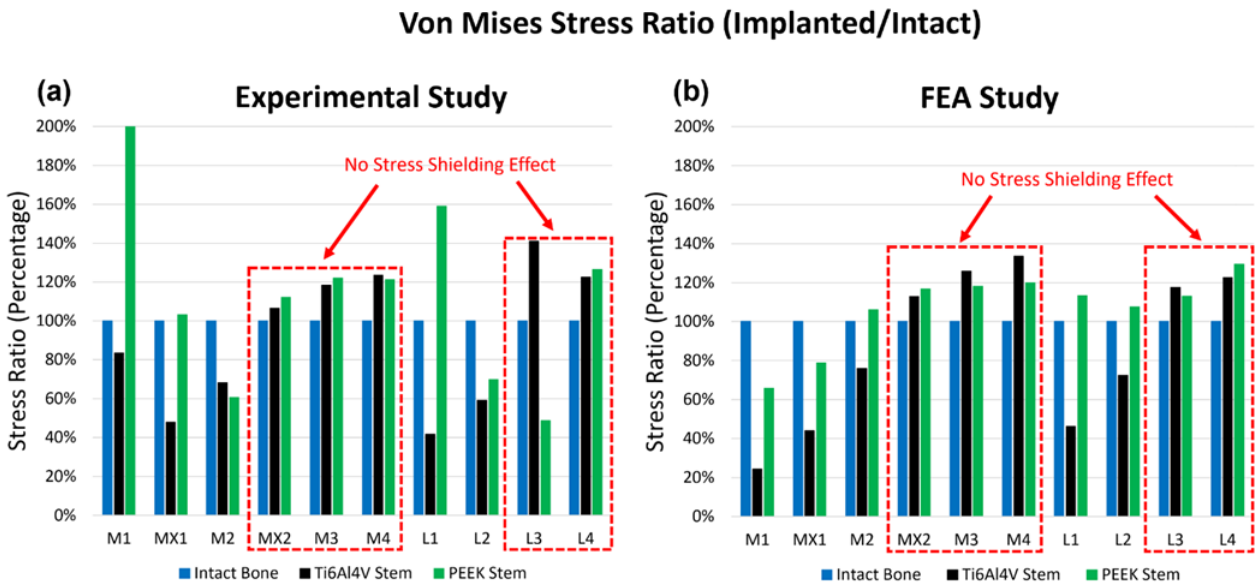
Figure 7. The stress ratio of the 10 points of interest for the intact bone, the Ti6Al4V Stem, and the PEEK Stem, obtained from experimental study ( a ) and FEA study ( b ). The x-axis demonstrates the rosettes strain gauge locations on the cortical bone. There were 4 rosettes (L1–L4) on the lateral side and 6 (M1–M4, MX1 and MX2) on the medial side.